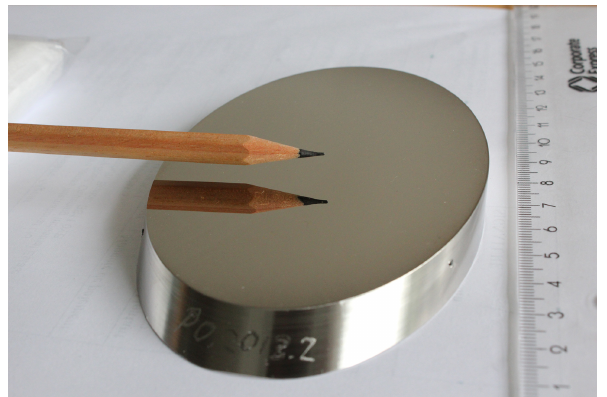
Figure 7. Stainless steel mirror with lapped and polished optical grade surface. Photo: D. Feist.